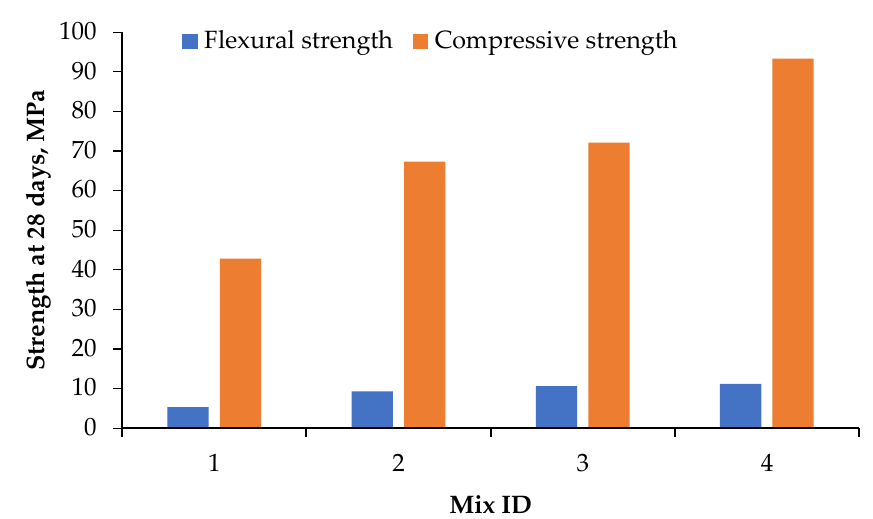
Figure 9. Compressive and flexural strength of developed fiber mortars. Table 4. Frost resistance and water absorption of the